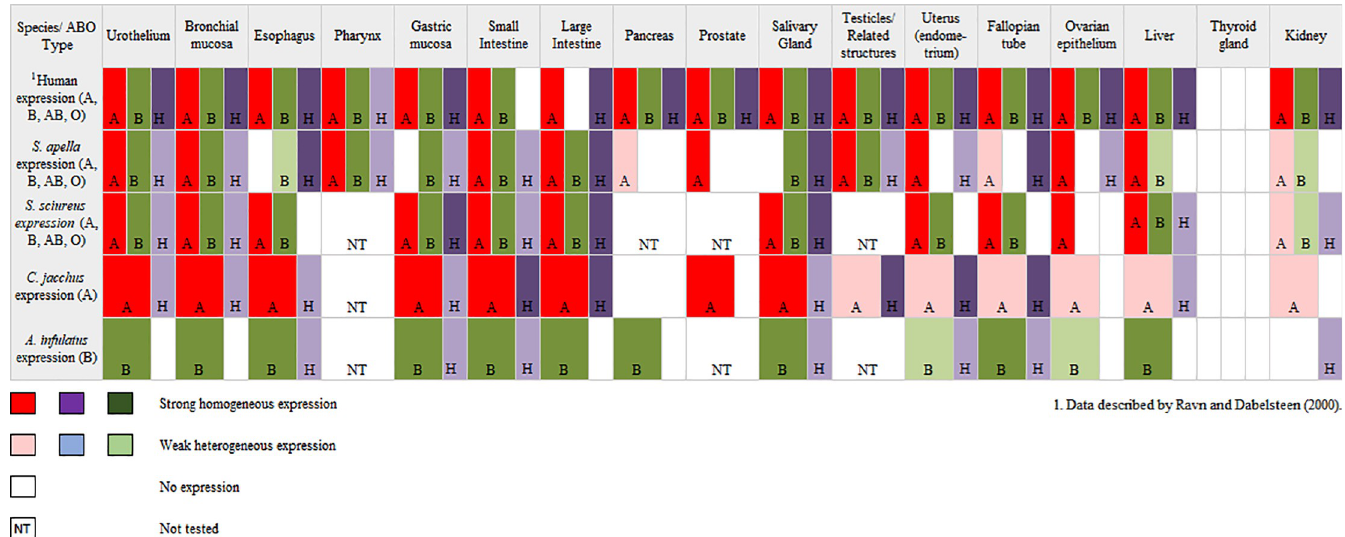
Fig 3. Schematic drawing of comparison of ABH histoblood group expression in several tissues from New World Monkey and human.